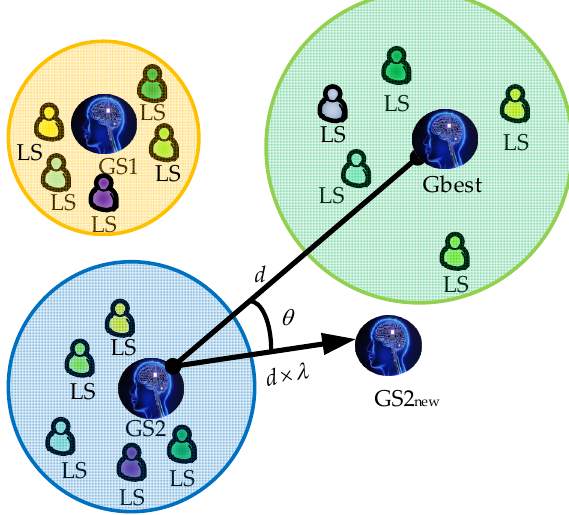
Figure 4. Random walk rule of the global searcher (GS).